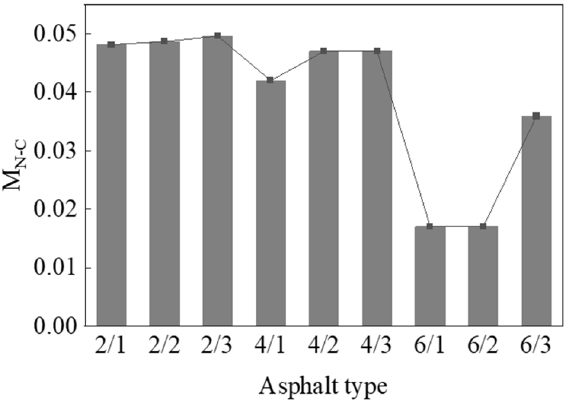
Figure 7. Changes of N - C bond content before and after asphalt aging.